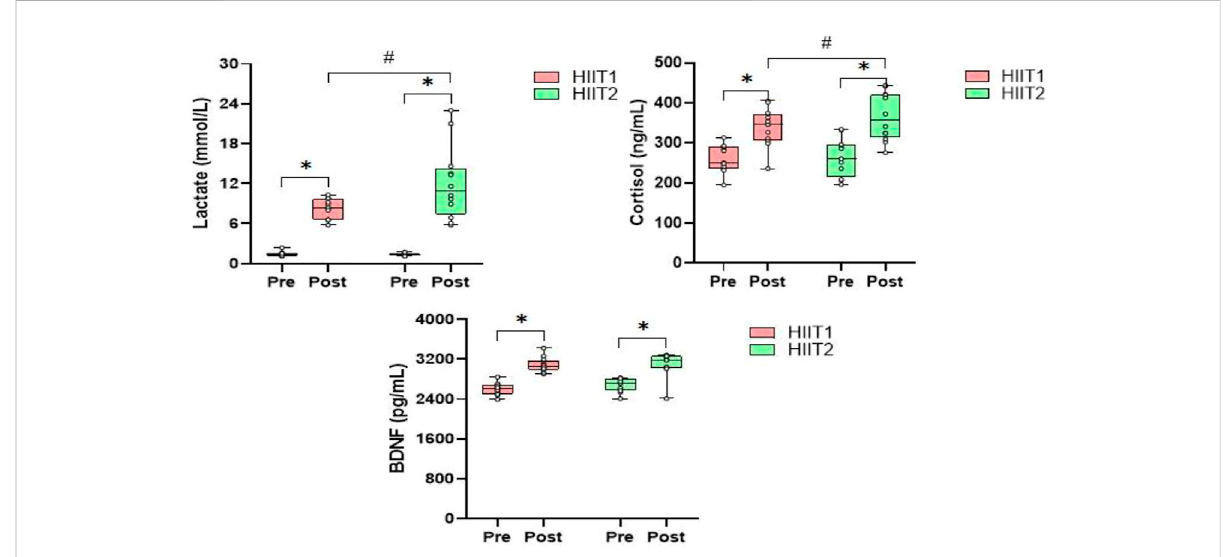
FIGURE 3 Therelativechanges(mean)inbloodlactate,serumcortisolandBDNFlevelsduringtheHIIT1andHIIT2protocolPreandPost.* p < 0.01postvs. Pre, # p < 0.05 difference between